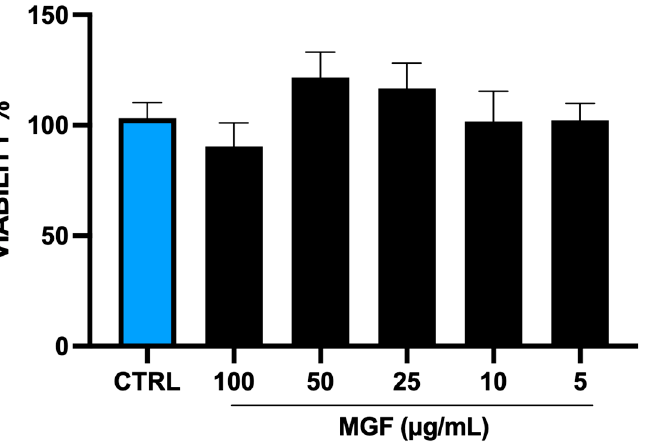
Figure 1. Cell viability determined by MTT assay on NCI-H292 cells, untreated and treated with MGF at different concentrations (30, 20, 10, 5, 1 μ g/mL) for 24 h.